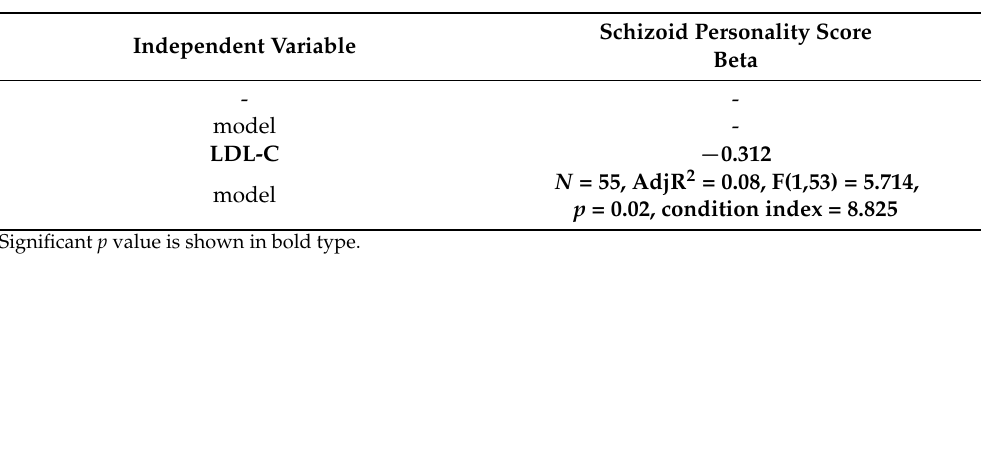
Table 4. Results of regression analysis (schizoid personality score as dependent